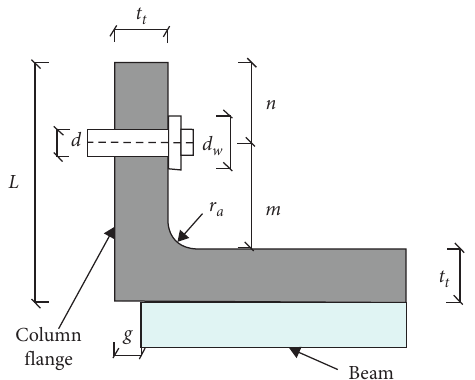
Figure 12: Calculation of effective bolt spacing (units: